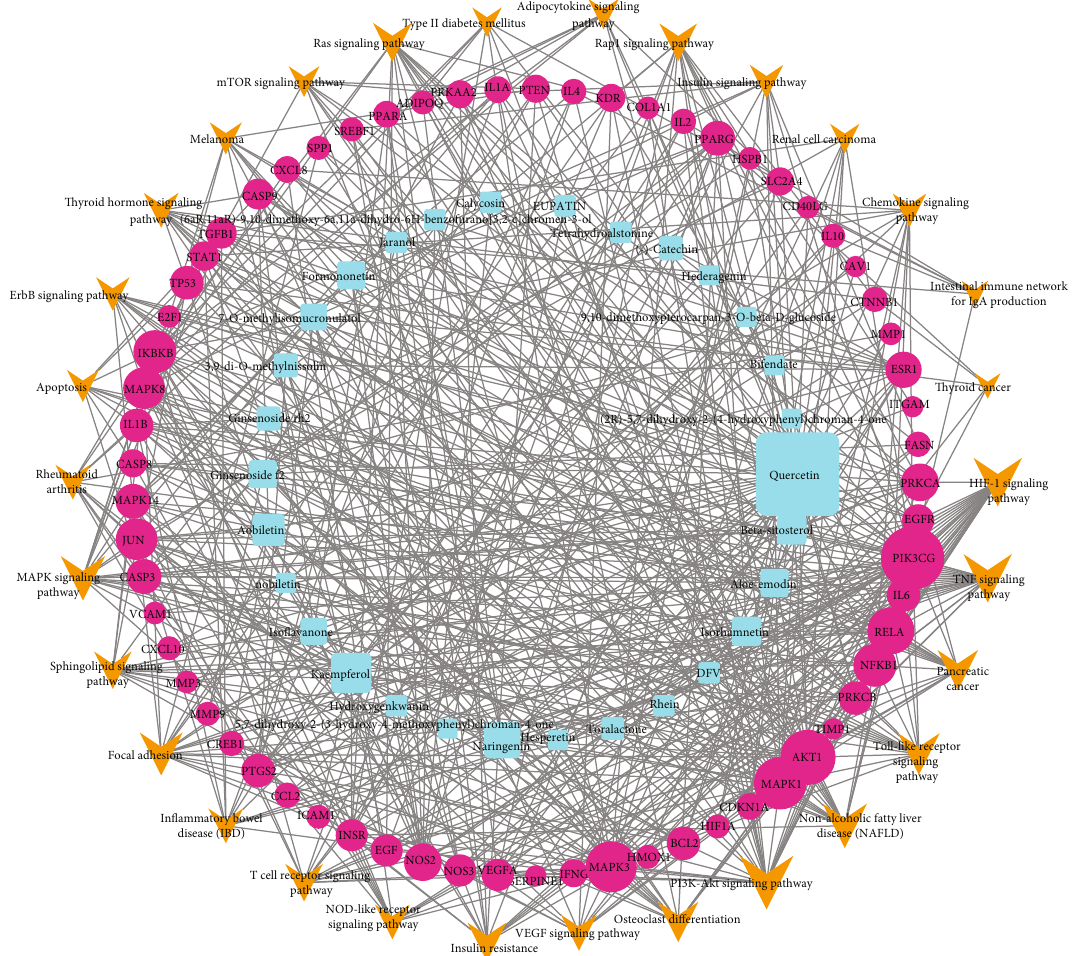
Figure 10: The compound-target-pathway network of Tangshen Formula (TSF). The blue square nodes represent compounds. The red circle nodes represent targets. The orange arrows represent pathways. The size of them represent the degree; the lines among inner nodes display the relationship among compounds, targets, and